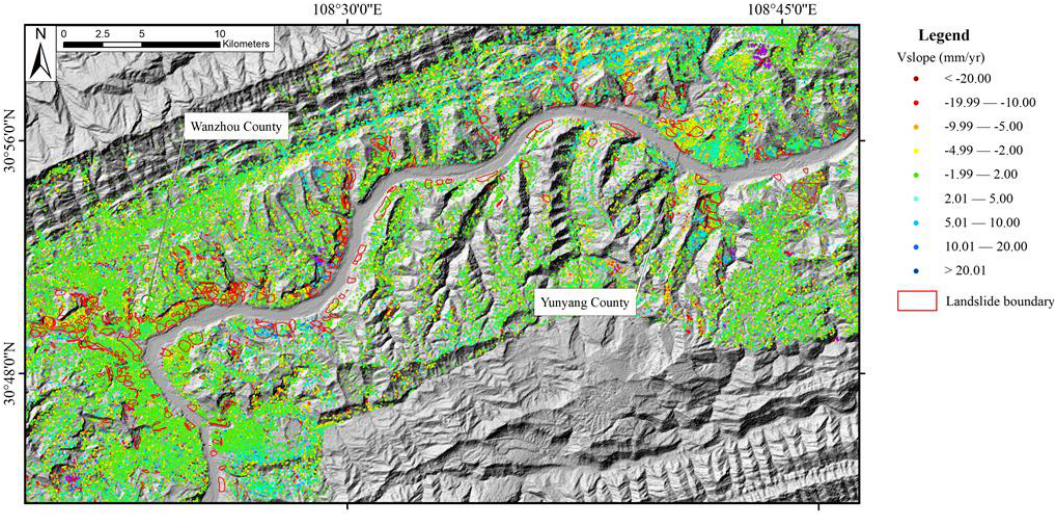
Figure 4. Displacement velocity (Vslope) map of the area generated from the Sentinel-1 data stack.